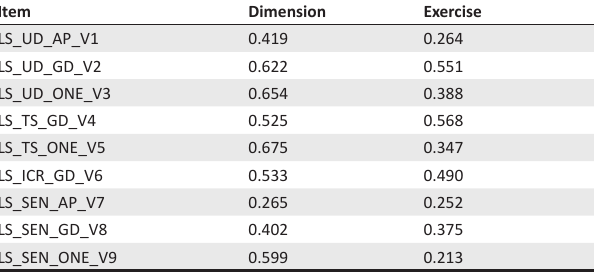
TABLE 5: Completely standardised factor loadings of 1D1E measurement model.